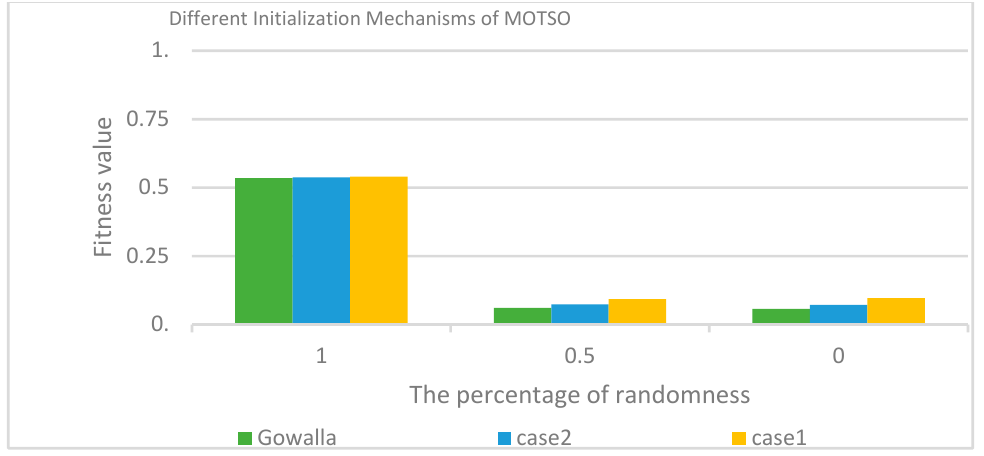
Figure 5. The fitness value when varying the initialization mechanisms. Table 9. Normalization values of the objectives in terms of minimization when varying the initiali- zation mechanisms.